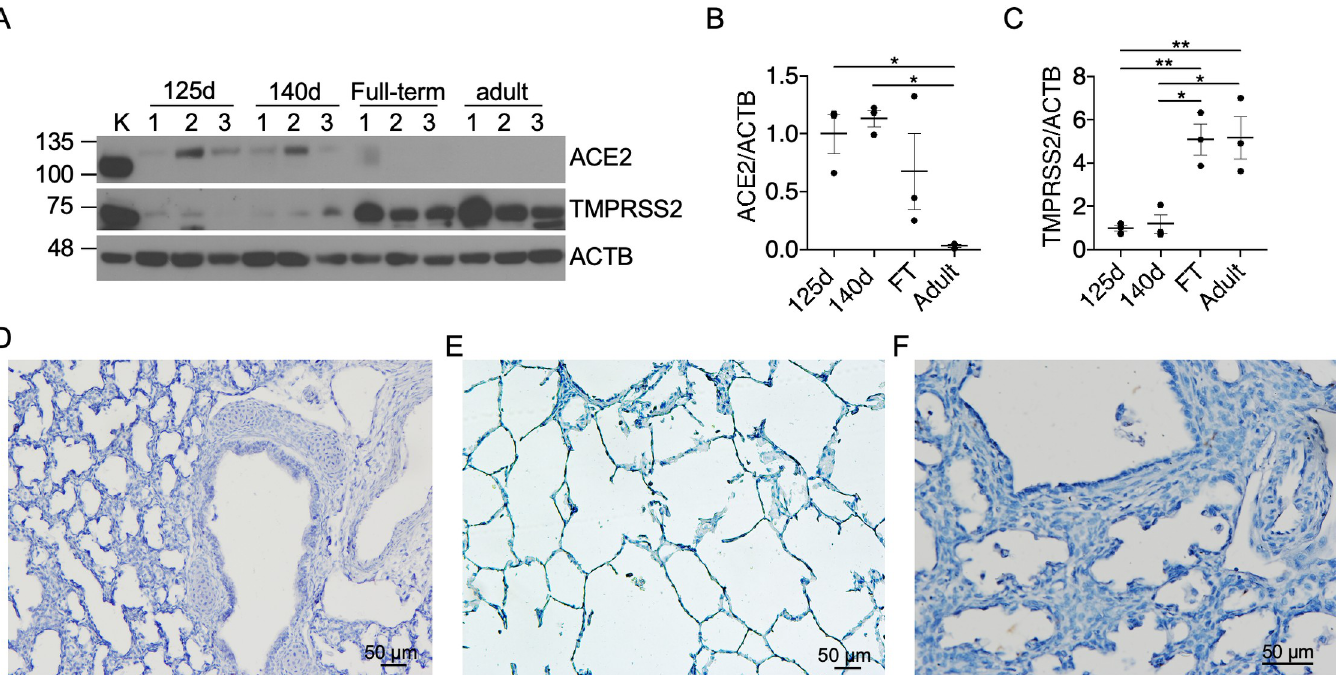
Fig 2. Expression of ACE2 is higher and TMPRSS2 is lower in preterm lungs compared to full-term and adult lungs. Representative immunoblots and densitometry of NHP ( P . papio ) lung homogenates from preterm (125d and 140d) and full-term newborn and adult animals demonstrate faint ACE2 expression in the 125d and 140d groups, but not in adult samples (A & B), whereas TMPRSS2 expression is significantly higher in adult lungs compared to other groups (A & C). Representative images of IHC for ACE2 in NHP ( P . papio ) lung tissues from preterm (125d) (D) and adult animals (E) as well as NHP lungs with BPD (F) demonstrate lack of ACE2 immunoreactivity. � p < 0.05, �� p <